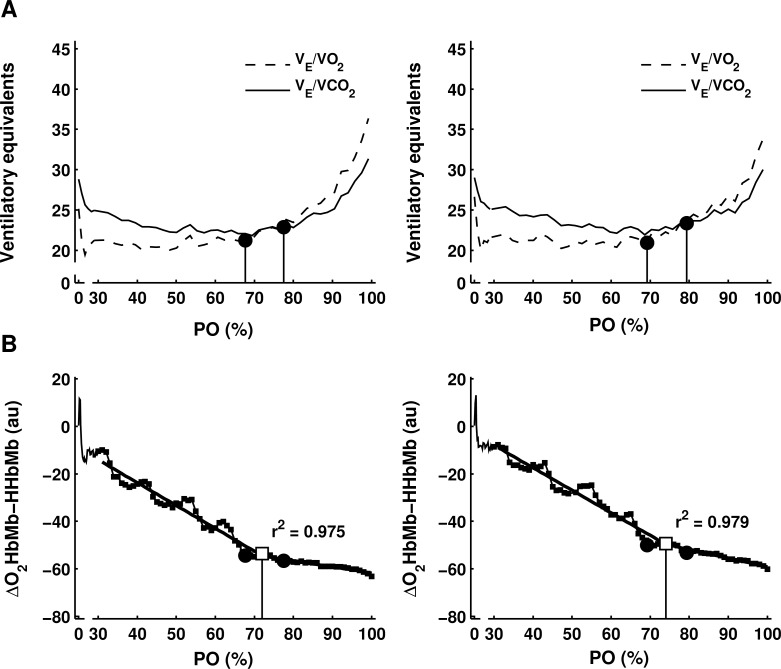
Typical example of detection of Δ[O2HbMb-HHbMb]-BP and ventilatory thresholds.Ventilatory thresholds VT1 and VT2 (closed circles) are depicted within the ventilatory equivalent versus PO graph (upper graphs, a). Δ[O2HbMb-HHbMb]-BP (open square) is derived from Δ([O2HbMb]–[HHbMb]) versus PO graph by means of double linear regression analyses with the least combined residual sum of squares (lower graphs, b). Both Δ[O2HbMb-HHbMb]-BP and ventilatory thresholds are determined for subsequent trials in a trained male cyclist for test (left graphs) and retest (right graphs).